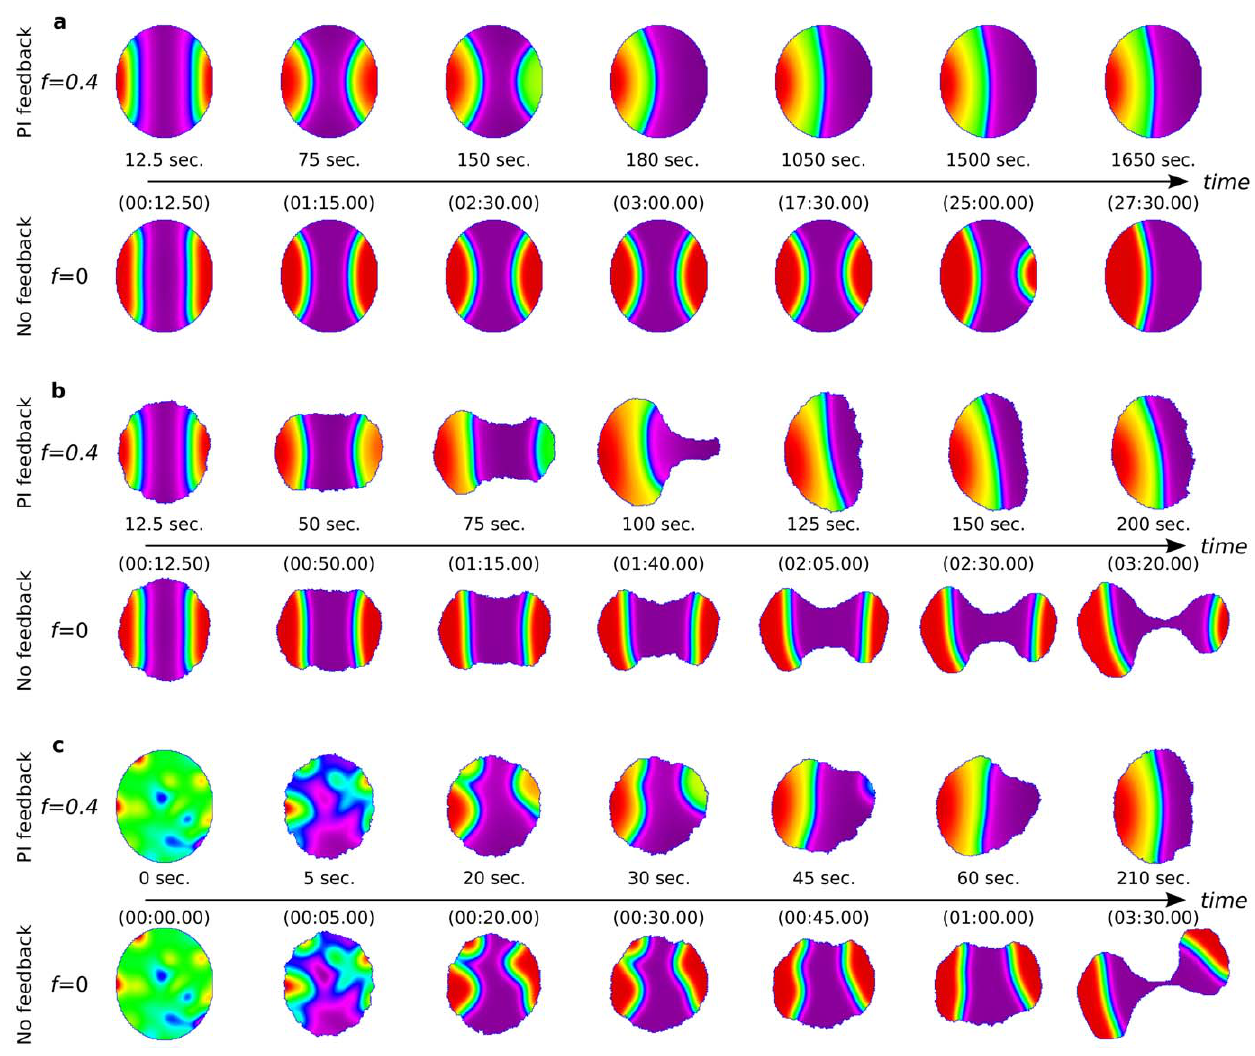
Figure 6. Resolving conflicts. Effect of phosphoinositide feedback ( f ~ 0 : 4 ) versus absent feedback ( f ~ 0 ) and cell shape dynamics on the response of cells to competing, conflicting, or noisy stimuli. (a) ‘‘V’’ shaped gradient with static cell shape. (See Video S6). (b) ‘‘V’’ shaped gradient with dynamic shape changes. (See Video S7). (c) Noise-induced fronts within motile cells. (See Video S8). PIs allow the cell to rapidly resolve the competition between contradictory